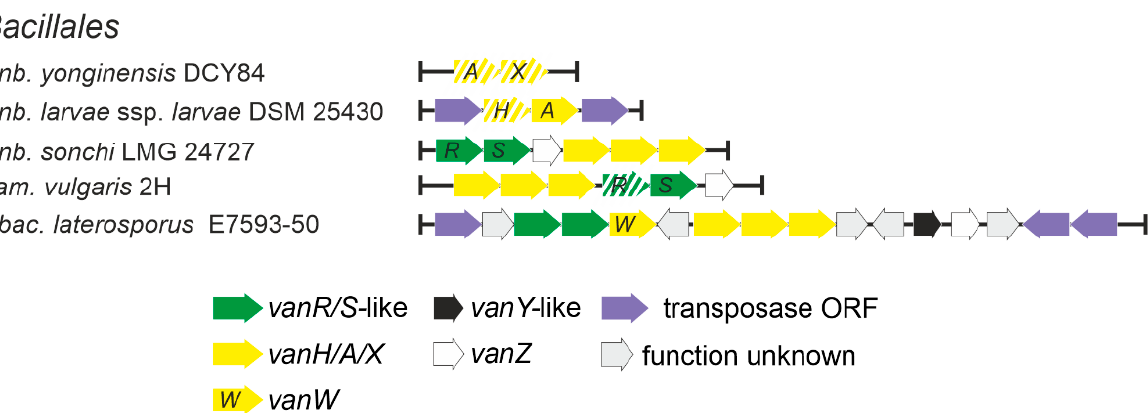
Figure 8. A scheme of putative MGEs found in ( a ) Er. mucosicola ( Eggerthellales ) and ( b ) Coriobacteriales spp. Pvb. caecicola and Atp. minutum (note that this MGE contains vanW gene – coding for a protein of unknown function). MGEs from Er. mucosicola and Pvb. caecicola seem to be almost identical (identical genes are joined with gray dashed lines), while MGE from Atp. minutum differs from both. The legend below the figure explains the color-coding of the scheme.